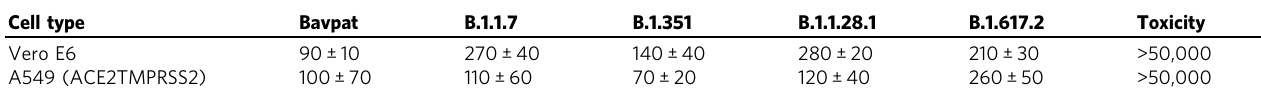
Data are averages of the EC 50 values ± standard deviation (SD) obtained from at least two independent experiments, each performed with duplicate